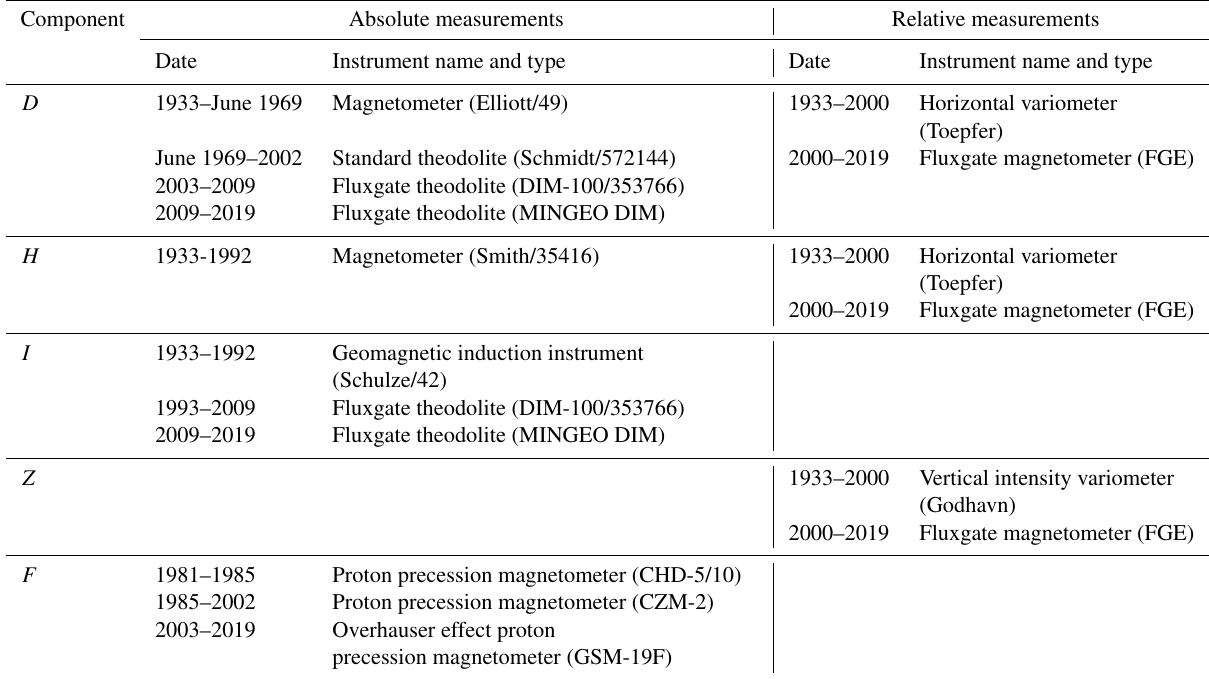
Table 1. Summary of instruments in the period from 1933 to 2019 at